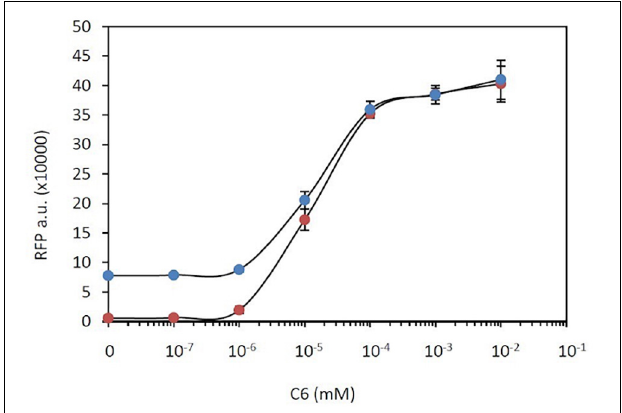
FIGURE 5 | Gene overexpression limitation. RFP expression in a double system that combines constitutive and C6-dependent expression (blue dots) compared with that in a single system with only C6-inducible RFP expression (red